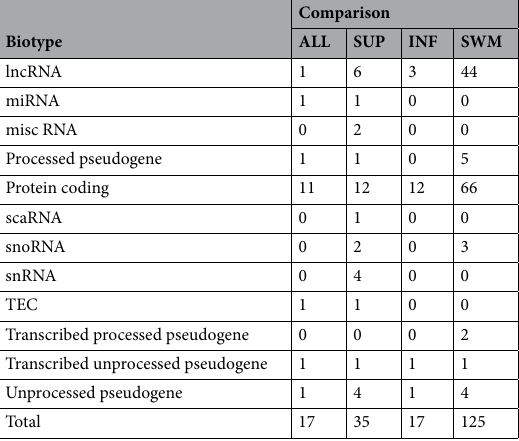
Table 3. Biotype of the DEG between HC and AD in each layer.